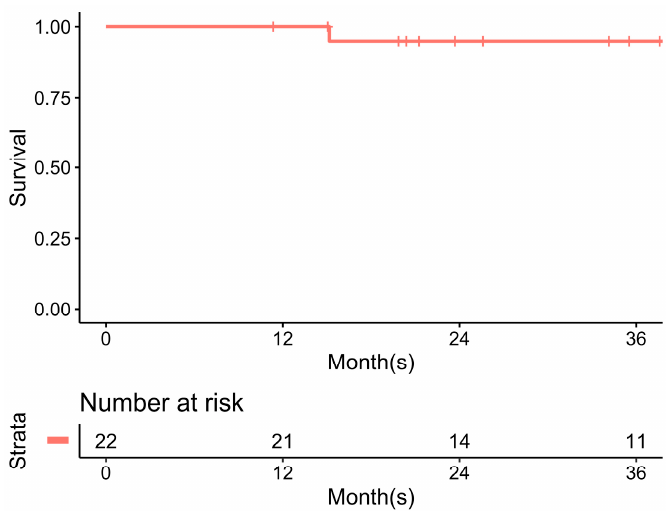
Figure 3. Disease free survival after neoadjuvant imatinib with plateau response and curative surgery.